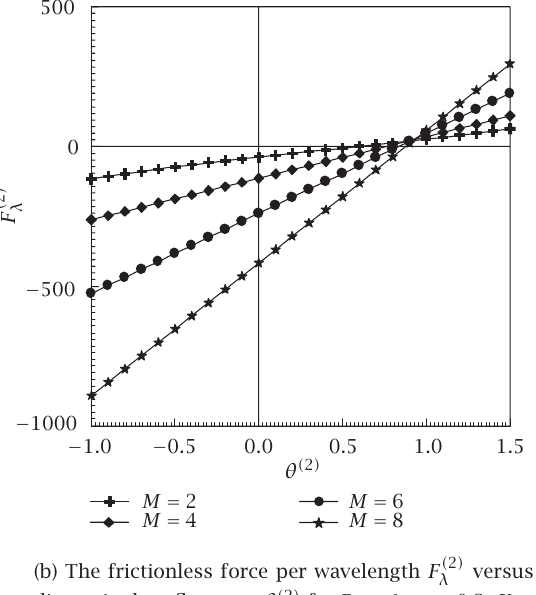
(a) The pressure gradient per wavelength (cid:5) p dimensionless flow rate θ ( 2 ) for Re = 1, ϕ = 0 . 3, K = 0 . 8, δ = 0 . 06, and different values of M .